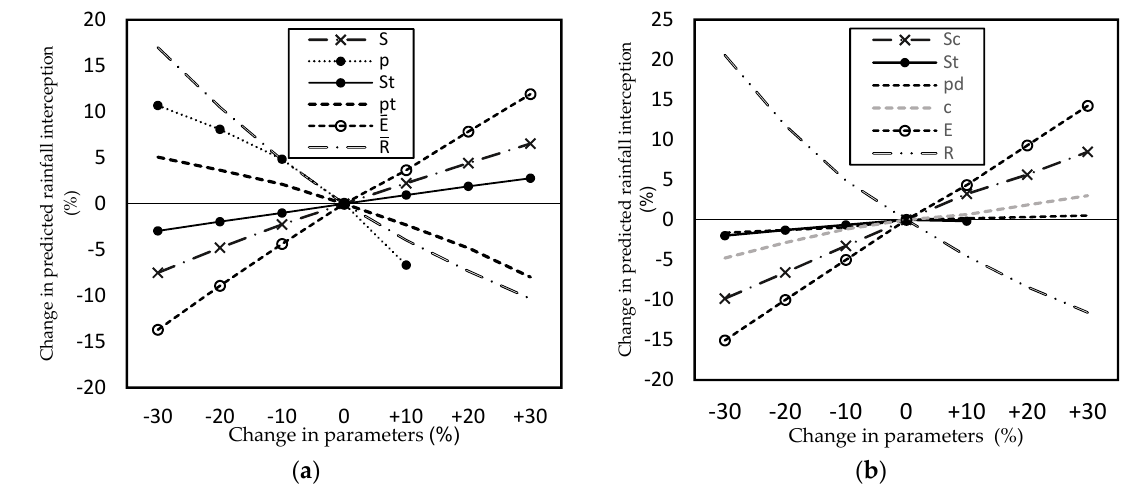
Figure 7. Sensitivity analyses of canopy parameters ( S , S c , S t , p , p t , p d , and c ) and meteorological parameters ( E and R ) of ( a ) Gash model and ( b ) Sparse Gash analytical